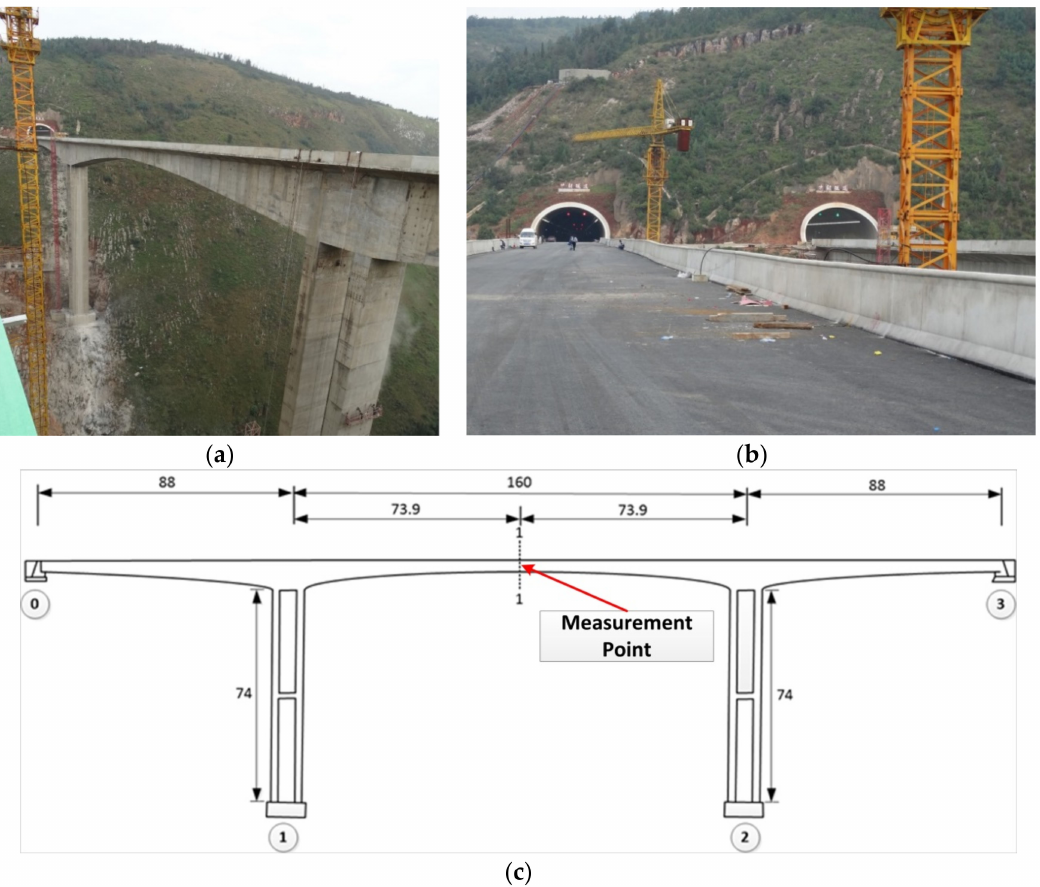
Figure 10. Bridge specifications (Measurement unit: m): ( a ) bridge structure; ( b ) bridge deck; ( c ) bridge